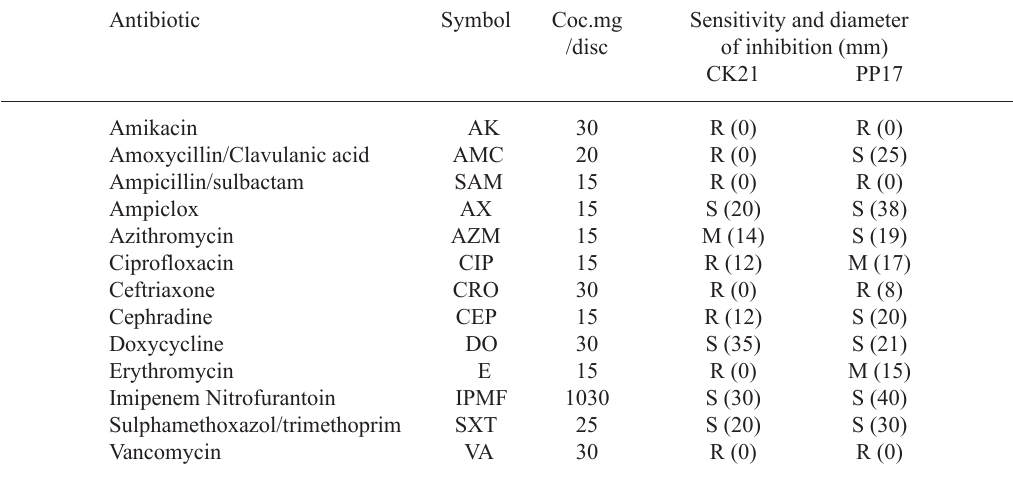
Table 4. Antibiotic sensitivity of LAB strains E. faceium CK21 and L. fermentum PP17 Antibiotic